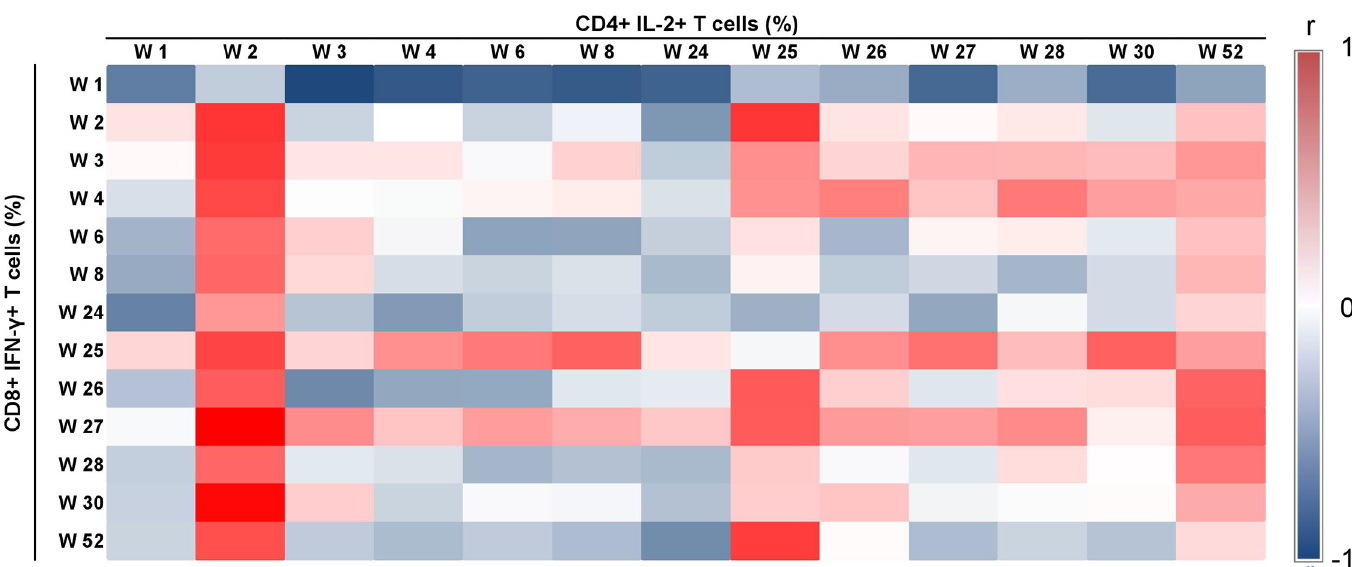
Fig 3. Heat map of Spearman correlation coefficients (r) between IL-2 producing CD4+ helper T cells (CD4+ IL-2+ T cells) and IFN- γ producing cytotoxic CD8+ T cells (CD8+ IFN- γ + T cells) in the rAd5-rAd5 group (Env ex-vivo stimulation of PBMC), HVTN 068 trial.